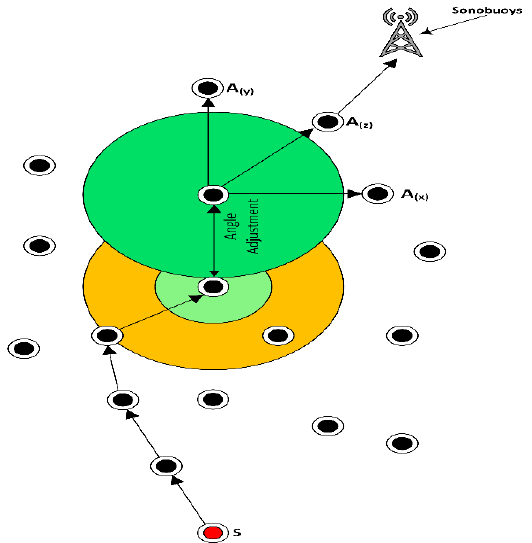
Figure 5. Tri-angular adjustment of horizontal A(x) , vertical A(y) and diagonal A(z) with reference to Figure 4.